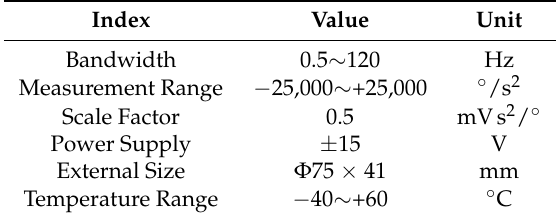
Table 5. Performance indexes of the liquid circular angular accelerometer (LCAA)